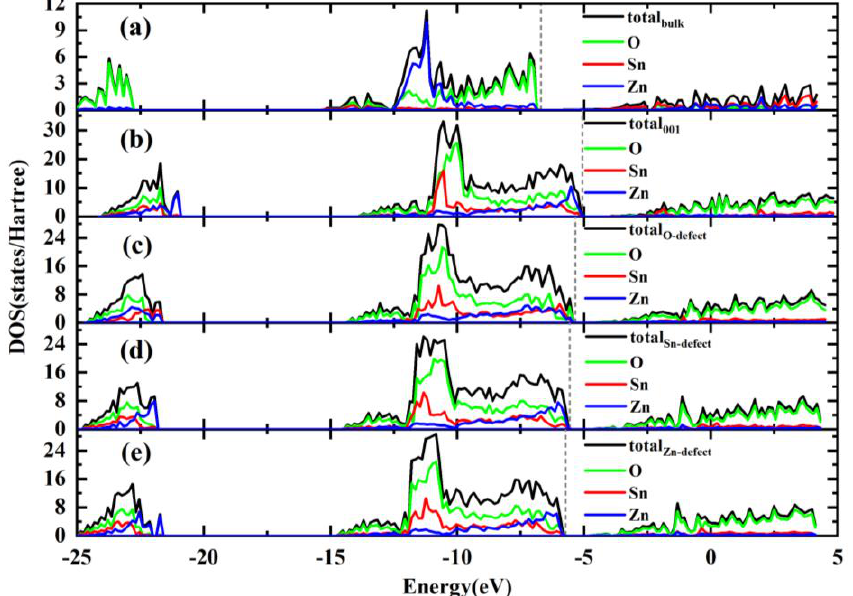
Figure 4. Density of states of ZS. ( a ) bulk; ( b ) perfect 001 surface; ( c ) V O surface; ( d ) V Sn surface; ( e ) V Zn surface.